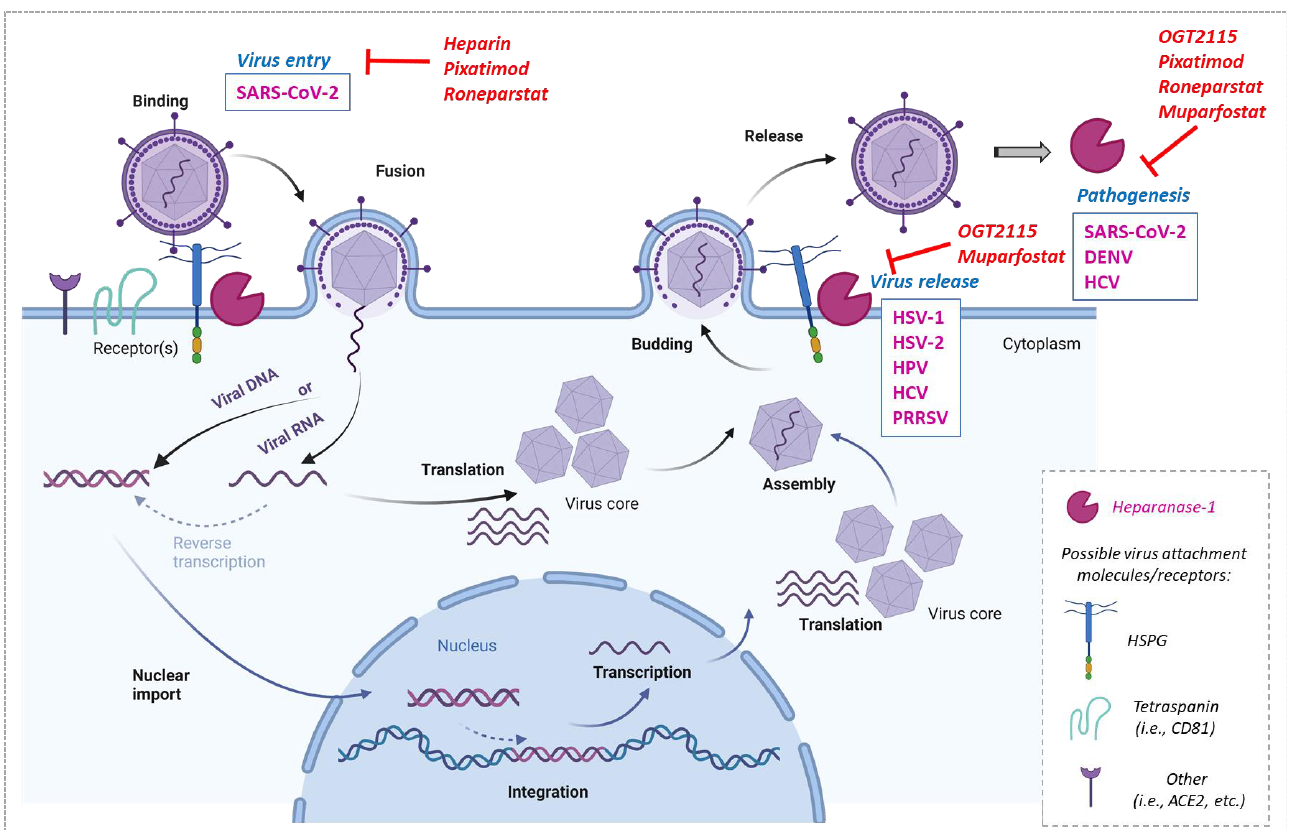
Figure 2. Impact of heparanase-1 on virus life cycles and their inhibition. Possible steps of the life cycle of RNA or DNA viruses for which heparanase-1 is thought to be involved are shown: binding and fusion. For an RNA virus without nuclear passage: translation and synthesis of viral proteins and genome, assembly of viral components, budding, and release of progeny virions. For an RNA virus with nuclear passage or a DNA virus: nuclear import (preceded by provirus formation in the case of retroviruses), integration (optional), transcription and synthesis of viral mRNAs, export and translation of viral mRNAs into viral proteins, assembly, budding, and release. Heparanase-1 is implicated in virus entry, release and/or pathogenesis when overexpressed. Inhibition of heparanase-1 with chemical compounds could block entry, release and/or pathogenesis of different viruses that require heparanase-1 during infection. [Created with BioRender.com].